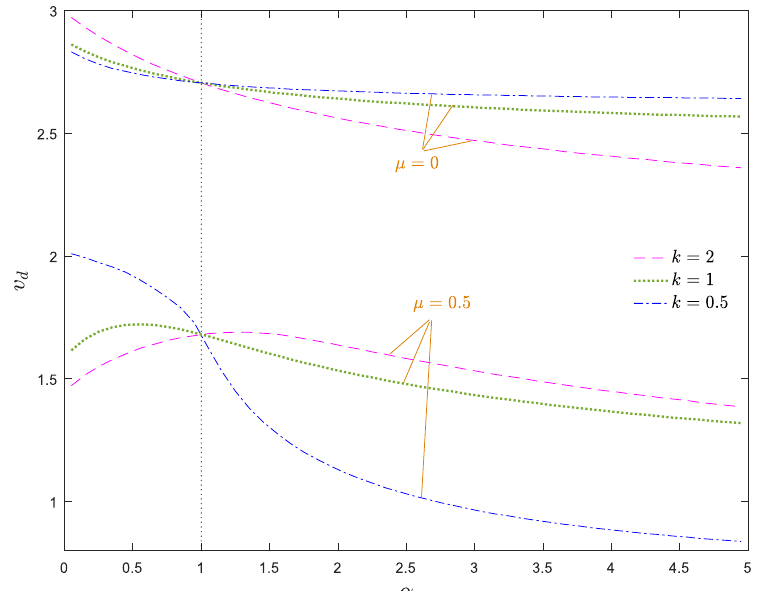
Figure 13. Dimensionless divergence velocity of the system against the gradient parameter for ζ = 0, k f = 0.5.